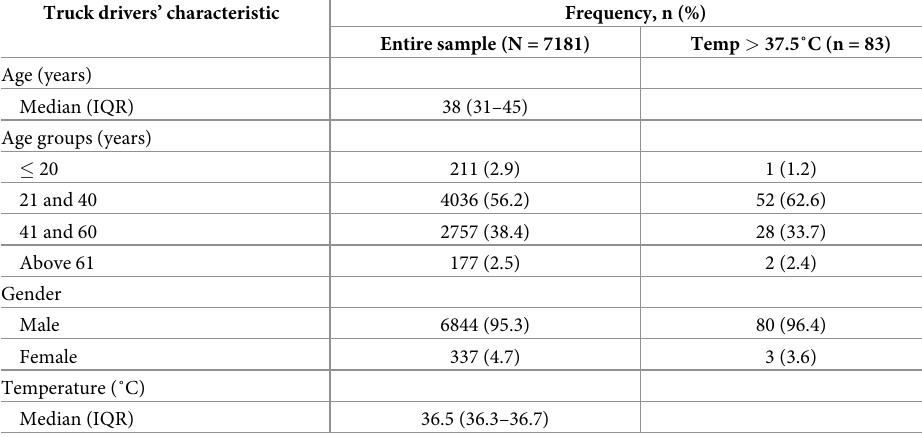
Table 1. The descriptive characteristics of the truck